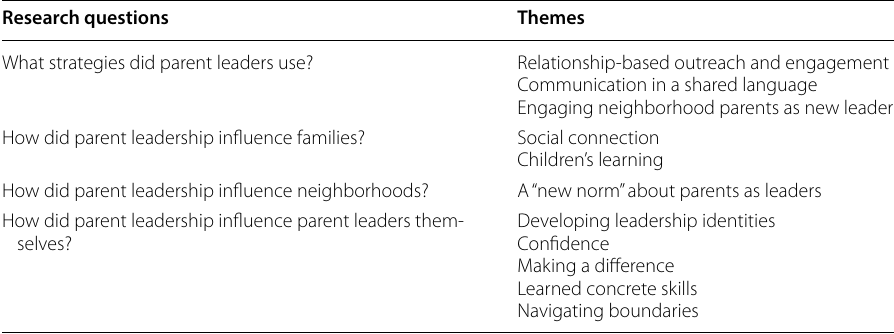
Table 4 Results themes Research